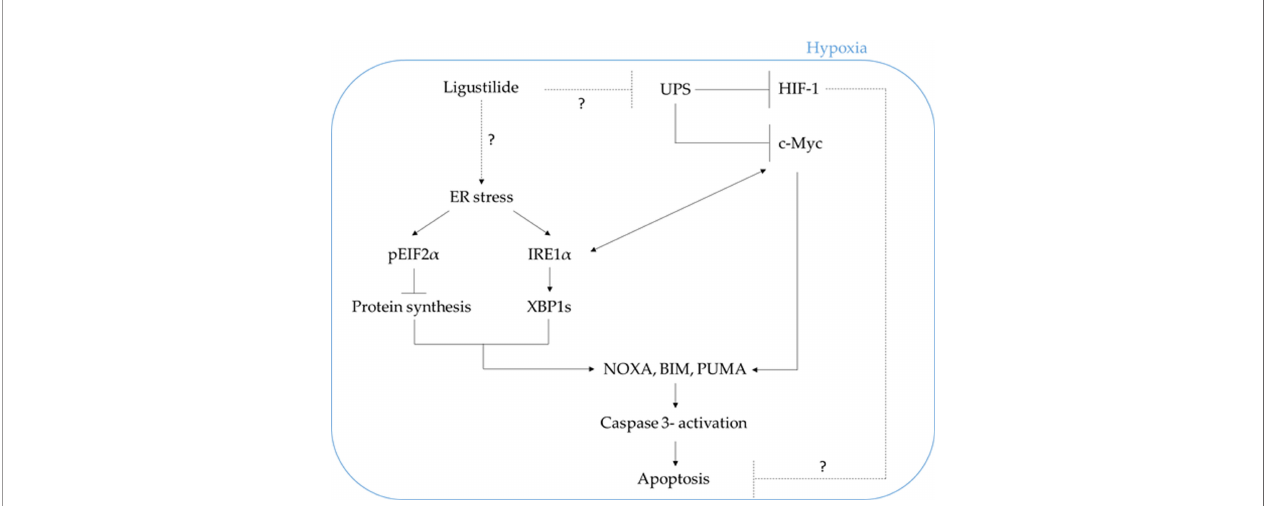
FIGURE 7 | The schematic plot illustrates the proposed pathway in which ligustilide-induced apoptosis in hypoxic oral cancer cells is dependent on c-Myc upregulation resulting from inhibition of proteasome degradation and elevation of ER-stress signaling. The role of HIF-1 in this system is not clear and awaits additional experimental